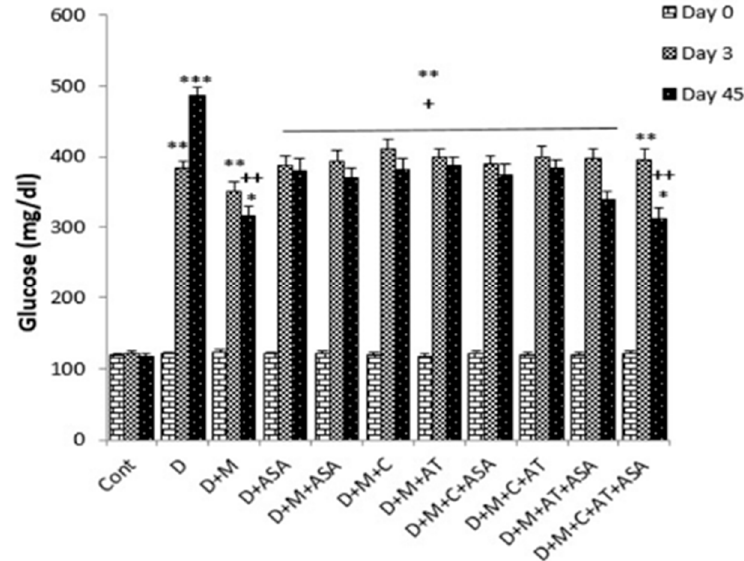
Figure 1. Glucose levels on days 0, 3 and 45 of the experimental period. Data are shown as mean ± standard error of the mean (SEM). * p < 0.05, ** p < 0.01 and *** p < 0.001 compared to control. + p < 0.05 and ++ p < 0.01 compared to diabetic group. D, diabetic; M, metformin; ASA, aspirin; AT, atrovastatin; and C, captopril.